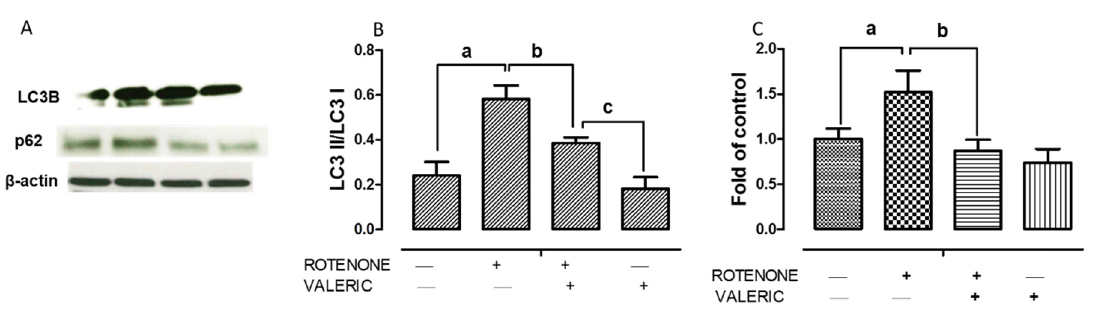
Figure 7. Valeric acid cosseted dopaminergic neurons by modulating autophagy. Immunoblotting of midbrain samples with autophagy markers LC3 II/LC3 I and p62 ( A ) from different groups. Quantitative analysis of immunoblotting of LC3-II/LC3-I ( B ) and P62 ( C ) both controlled by β -actin, respectively. Values are expressed as mean ± SEM. a p < 0.05 compared to control, b p < 0.05 compared to rotenone treated group, c p < 0.05 compared to Rot+Val treated group.